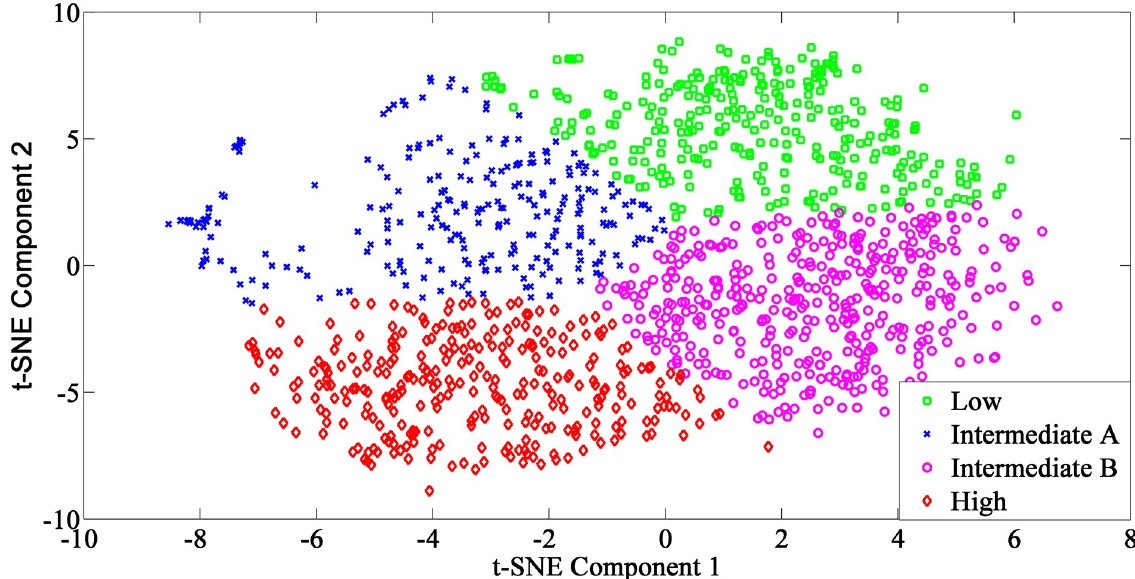
Fig 3. Clustering result generated by k-means clustering algorithm using features extracted from t-SNE. Low, Intermediate A, Intermediate B, and High represent the four clusters and grouped based on their